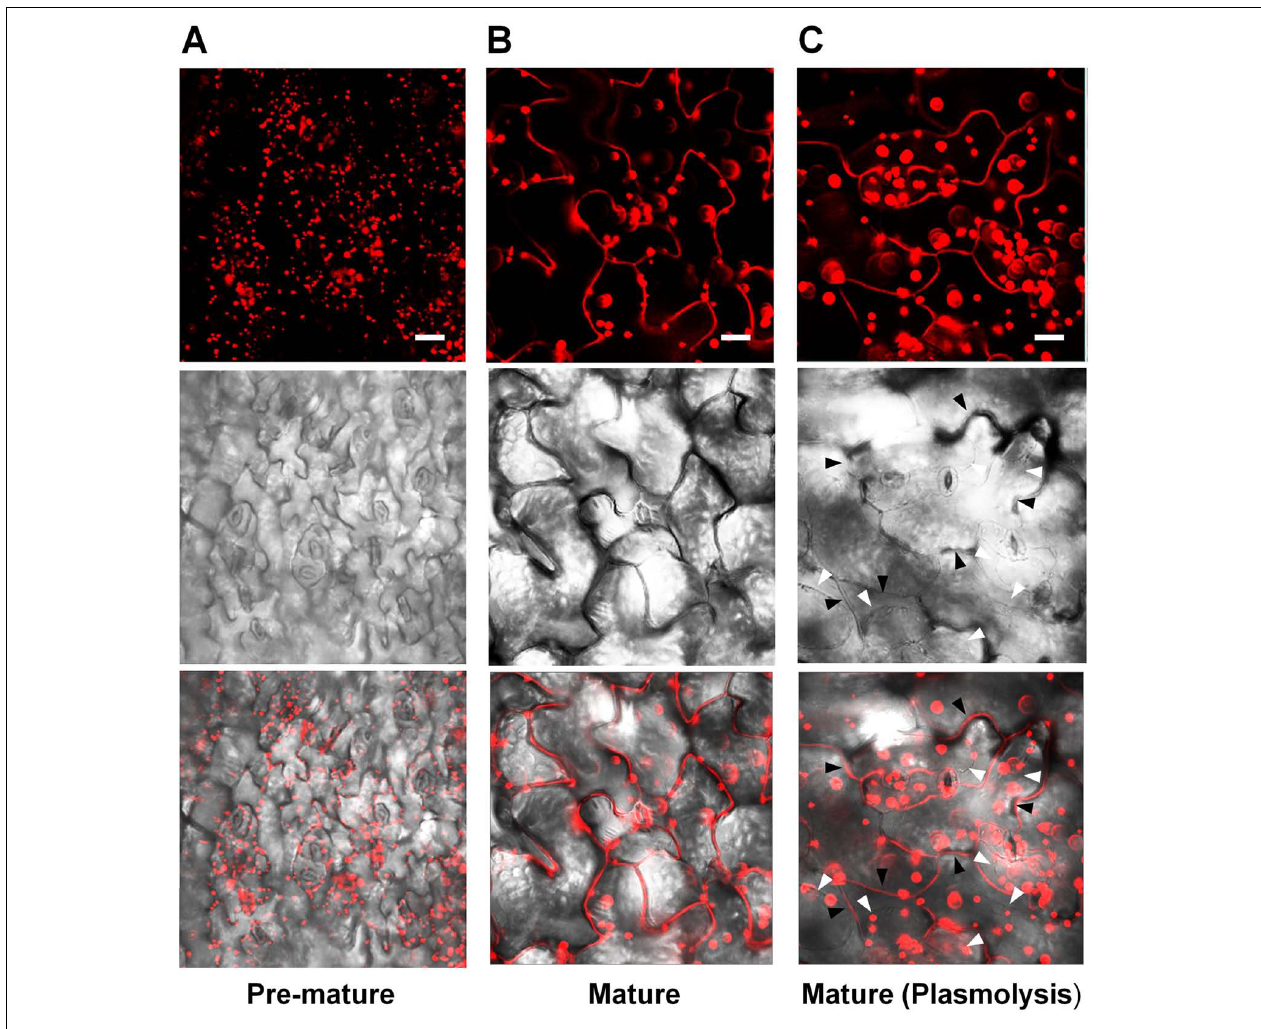
FIGURE 2 | Subcellular localization of PLA 2 α at different leaf ages in PLA 2 α -RFP transgenic Arabidopsis plants. (A,B) Epidermal cells in pre-mature leaf tissues (A) and mature leaf tissues (B) from Pro35SPLA 2 α -RFP transgenic Arabidopsis plants (4-week-old) were viewed using confocal microscopy. (C) Mature leaf tissues were incubated in 1 N KNO 3 to induce plasmolysis before being viewed with confocal microscopy.